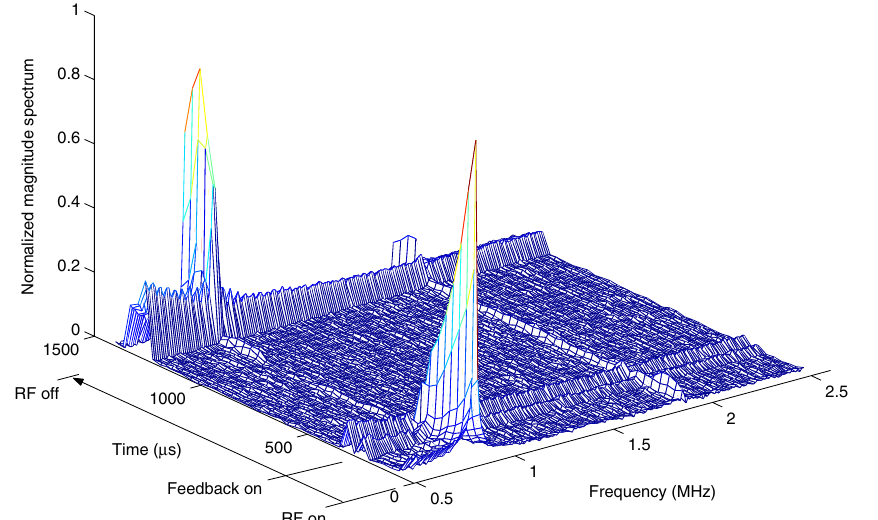
FIG. 13. (Color) 5 = 6 (cid:3) mode excited by the switching of rf power. The measurement was made on cavity SCL-13a running in closed- loop